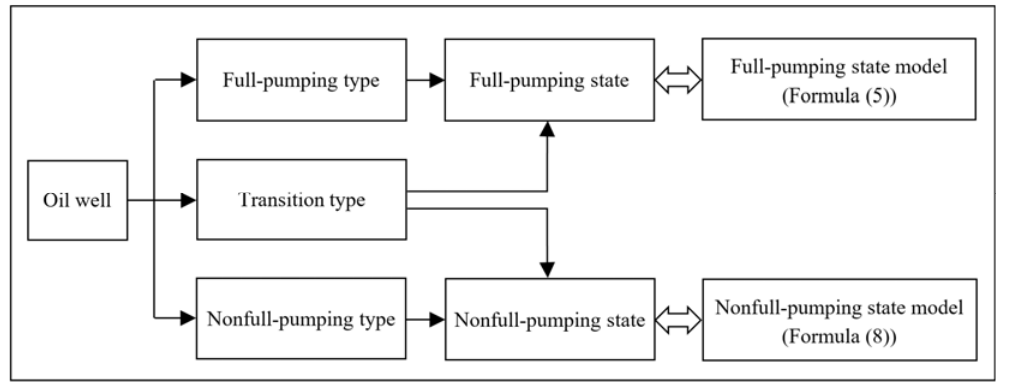
Figure 1. Relationship between oil well types and pumping states.